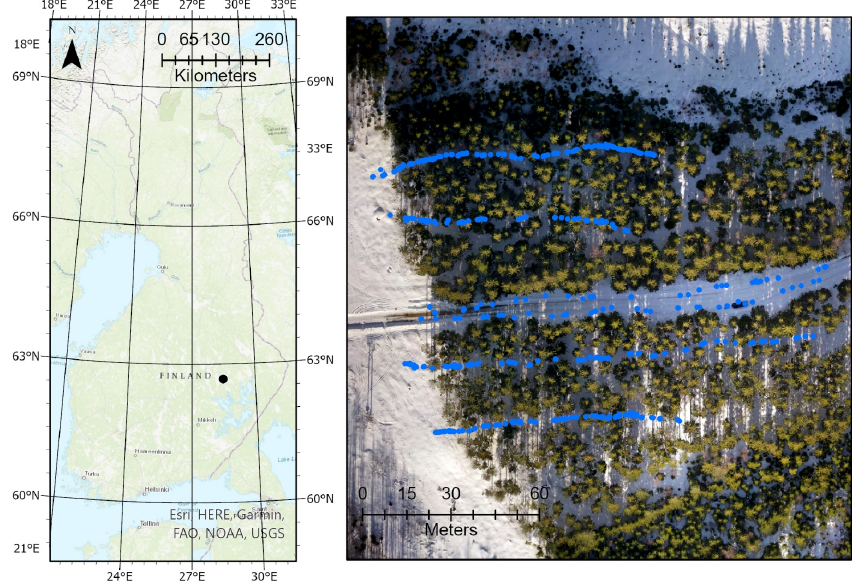
ground: unmanned aerial vehicle (UAV) and red, green, blue (RGB) image mosaic.